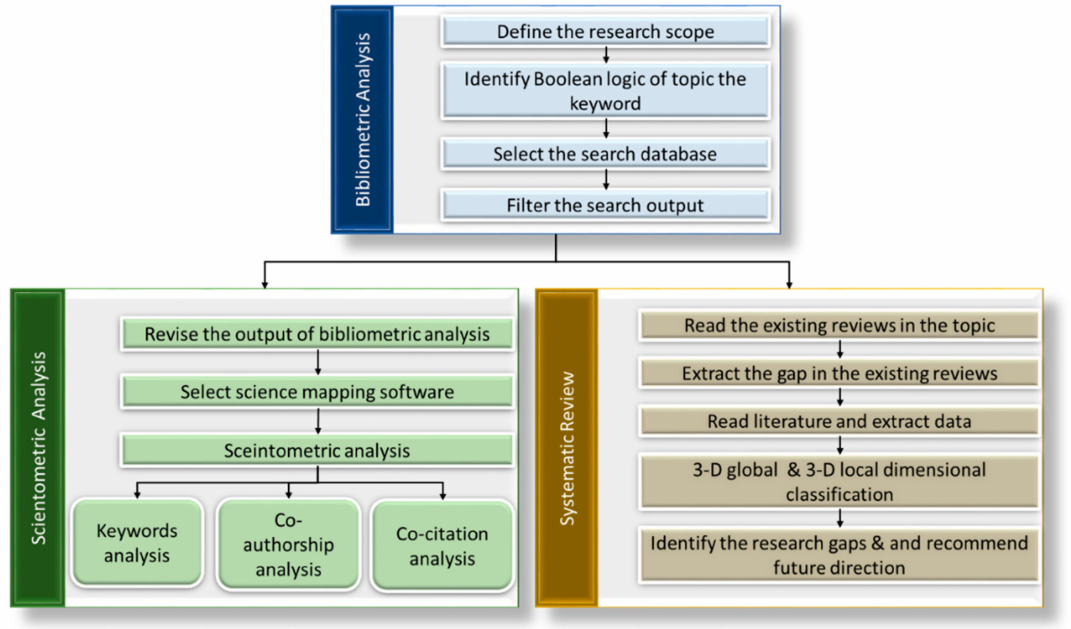
Figure 1. Summary of the review